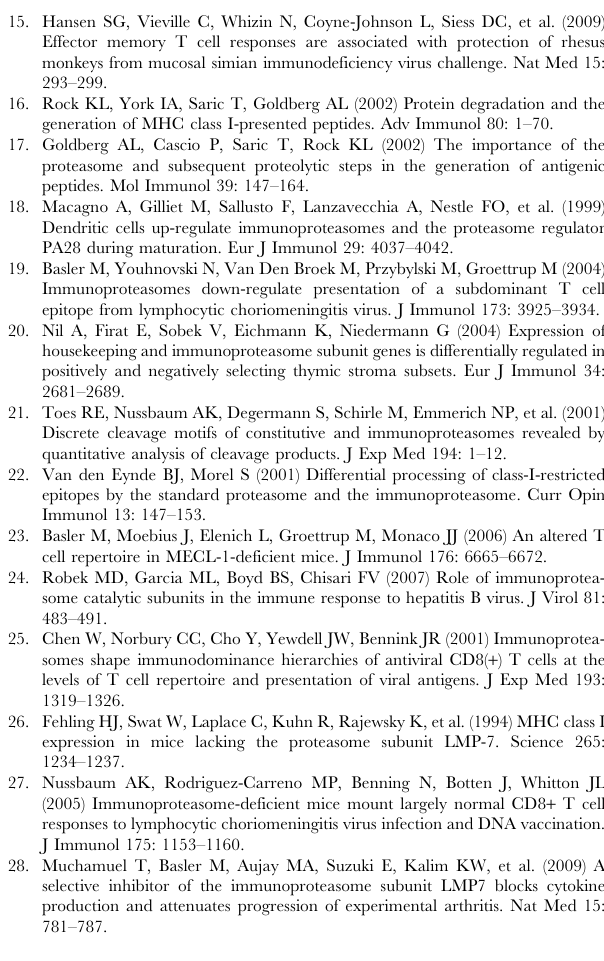
Table S2 Primers used for sequencing full-length gene